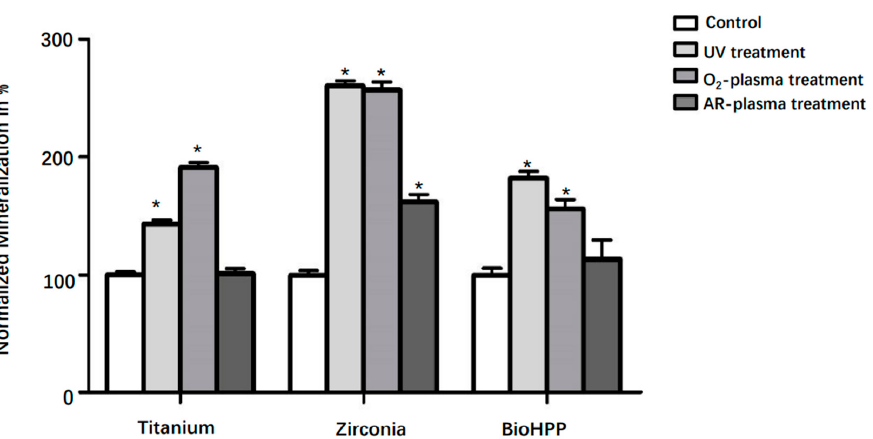
Figure 5. Mineralization of osteoinductive DPSCs on different surface treated titanium, zirconia and BioHPP after 21 days. Although any surface treatment led to increased mineralization on titanium, zirconia and BioHPP disks, differences were only significant after UV light and oxygen treatment on all three types of materials and argon treatment on zirconia ( p < 0.05). * p <